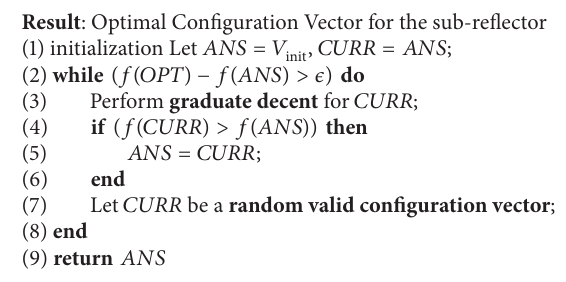
Figure 6: The final model of the adaptive subreflector, with its con- trolling software.